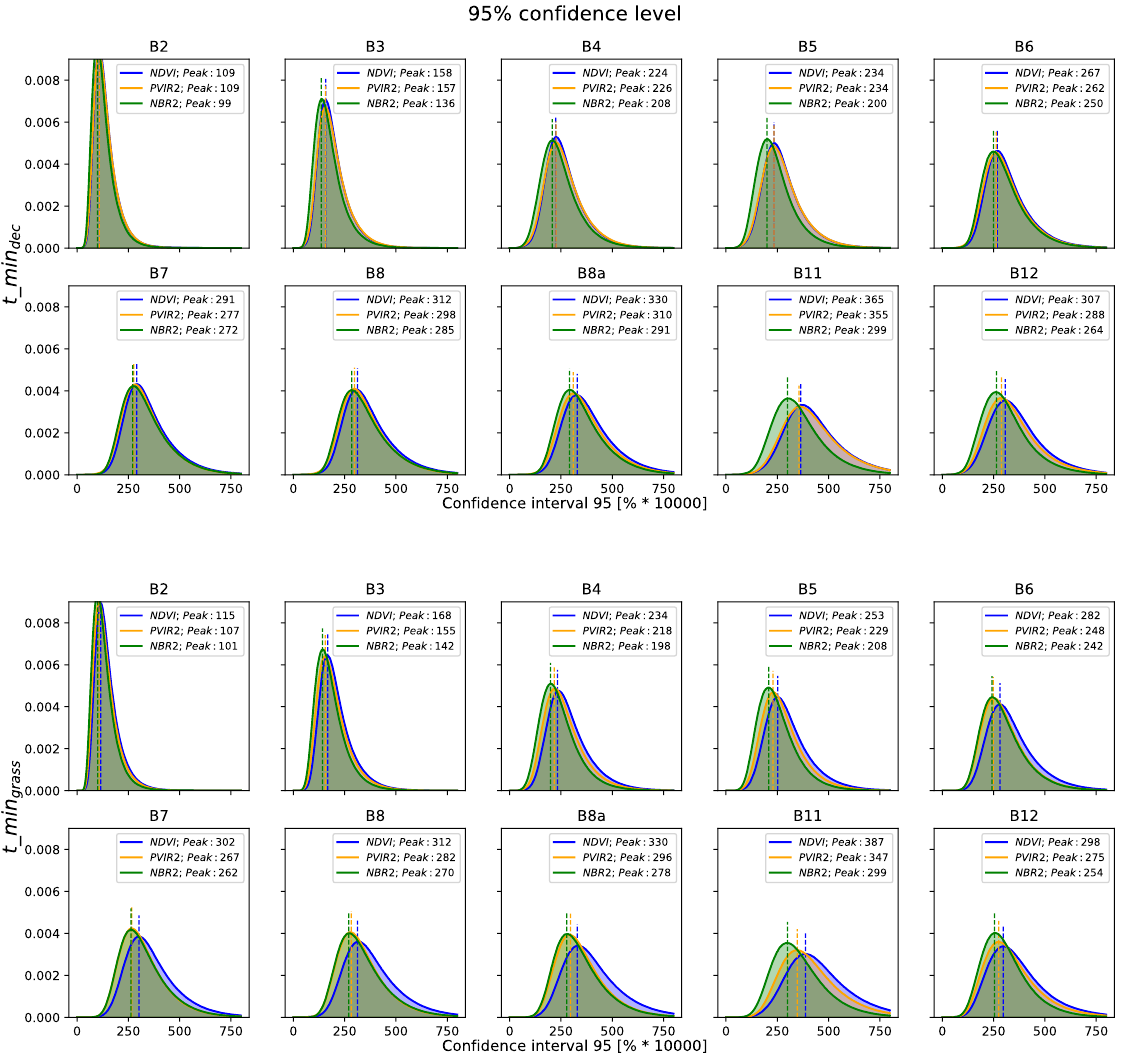
Figure 12. The band-wise histogram plots compare the distribution of the CI for the generated SRC spectral index versions. A kernel density estimate is overlaid to highlight the differences between the spectral indices.